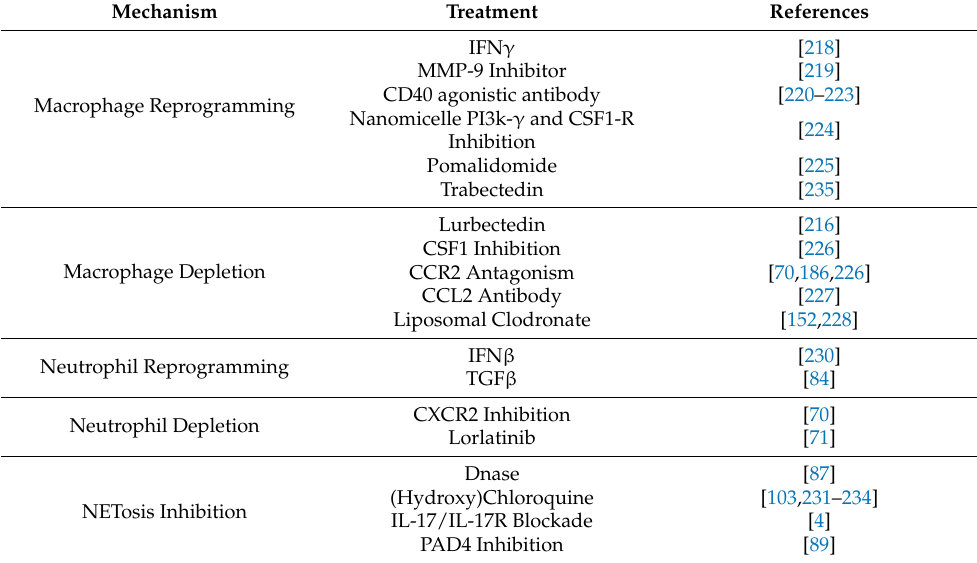
Table 2. Possible therapeutic strategies that can be used to target macrophages and neutrophils in